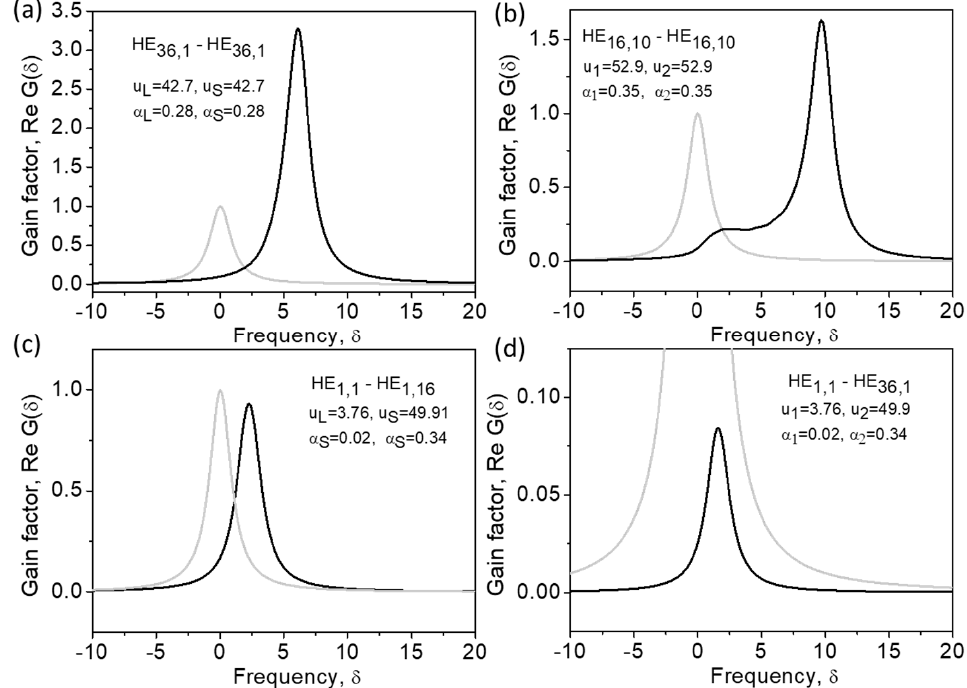
Figure 8. Brillouin gain spectra in the cases of interaction between eigen modes of different orders ( a – d ) in an optical fiber. Calculations are performed using Equations (26) and (27).